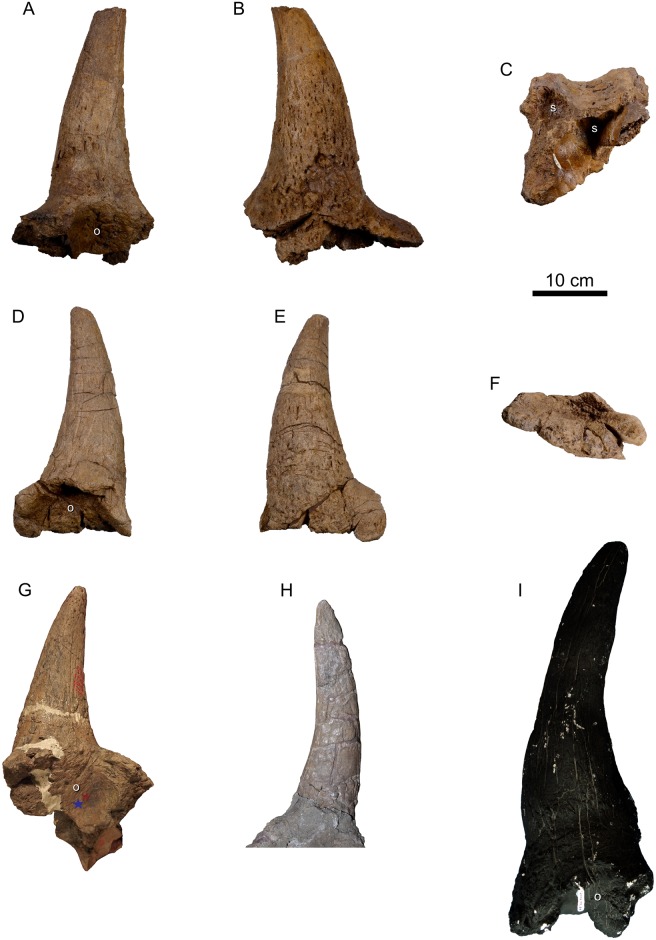
Postorbital horncores of Spiclypeus shipporum gen et sp. nov. (CMN 57081) and other chasmosaurines.Right postorbital horncore of S. shipporum (CMN 57081) in ventrolateral (A), dorsomedial (B), and ventral (C) views; left postorbital horncore of S. shipporum (CMN 57081) in ventrolateral (D), dorsomedial (E), and ventral (F) views; left postorbital horncore of ‘Ceratops montanus’ (USNM 2411) in ventrolateral view (G); left postorbital horncore of Kosmoceratops (UMNH VP 17000; courtesy of UMNH) in ventrolateral view (H); right postorbital horncore of Albertaceratops (TMP 2002.003.0036) in ventrolateral view (I).